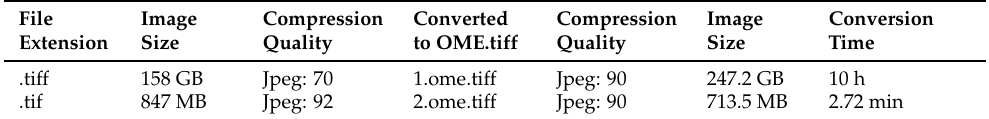
Table 4. Conversion of unrecognized WSI image into OME.tiff.